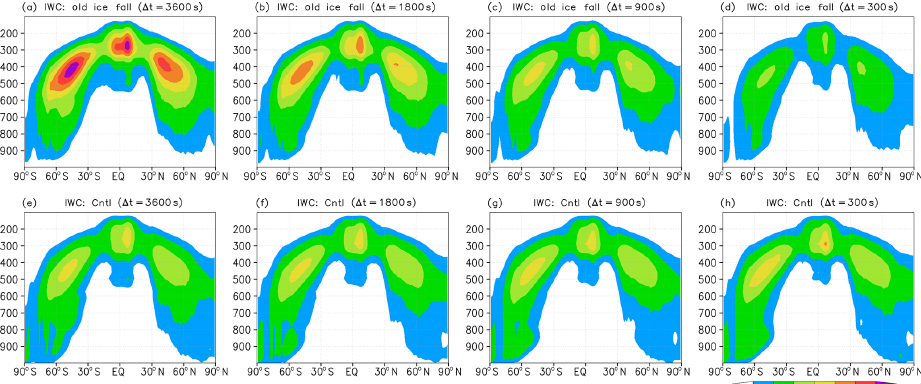
Figure 10. Zonal average of ice water content (mgkg − 1 ) for different model time steps. Panels (a, b, c, d) show results using the old ice fall scheme and panels (e, f, g, h) the control simulation using the modified ice fall scheme. From left to right, the time steps are 3600, 1800, 900 and 300s. The vertical axis shows air pressure (hPa) and the horizontal axis shows